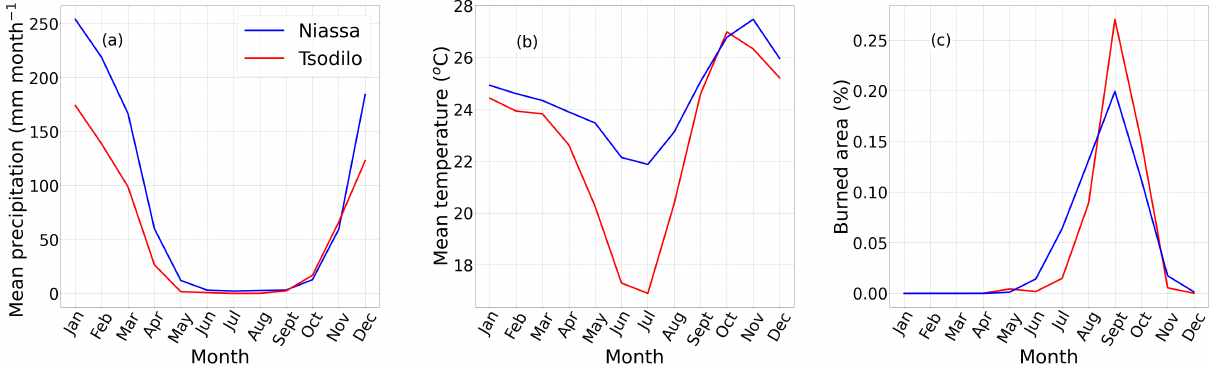
Figure 3. Monthly means of rainfall ( a ), temperature ( b ) and percentage of the region burned ( c ) for both study regions in the period from 2001–2016. Precipitation and temperature averages were calculated from the ERA-5 land dataset [23] and burned area from MODIS MCD64A1 C6 [28]. The area from which data were included for these calculations is shown in Figure